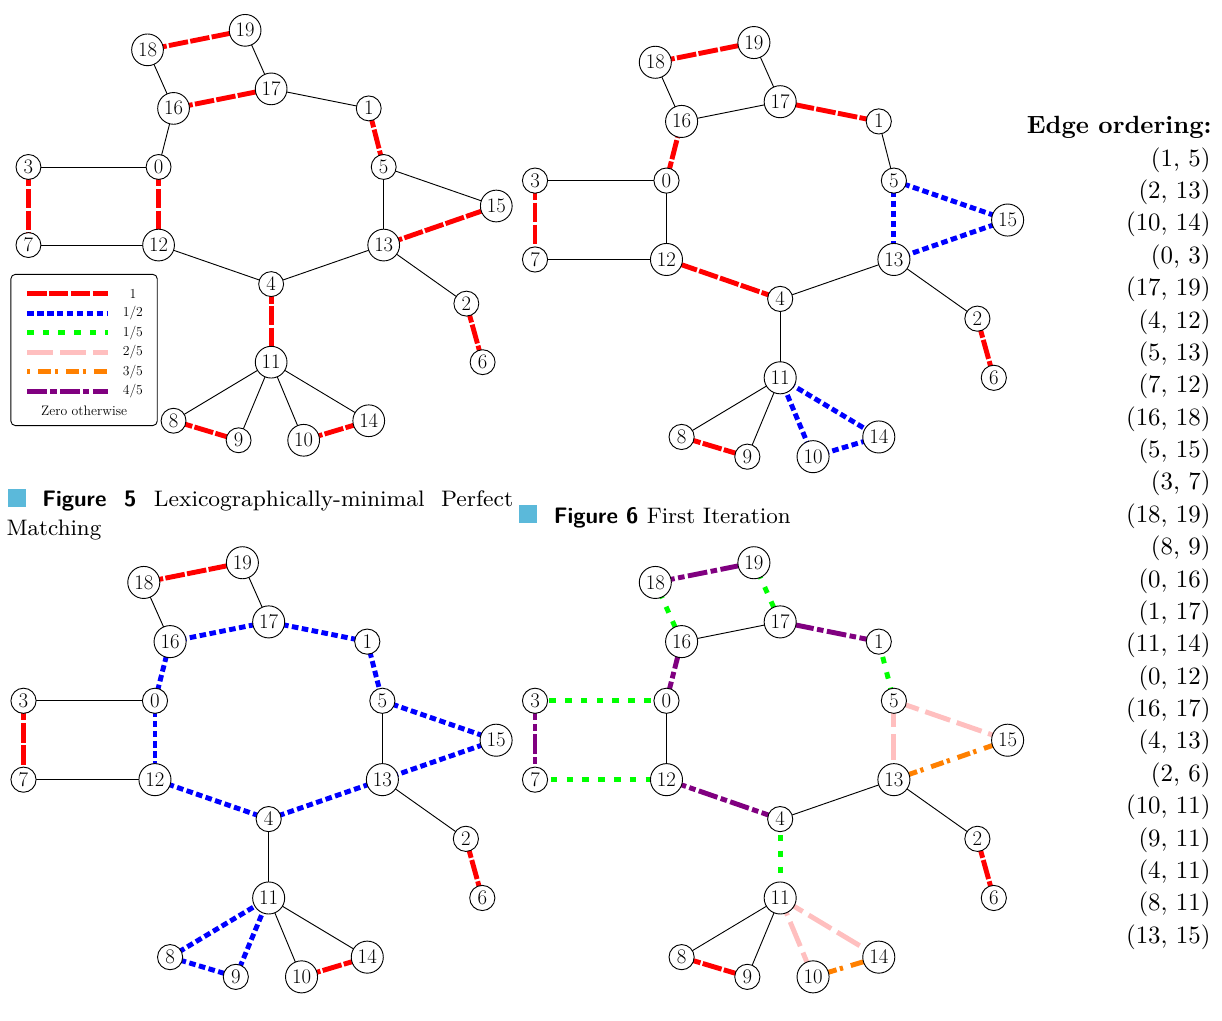
Figure 7 Second Iteration Figure 8 Third